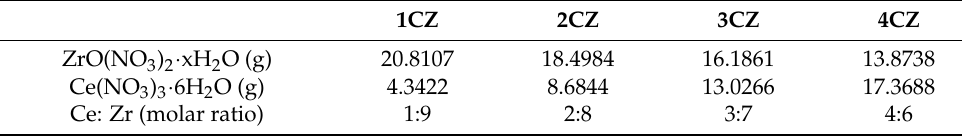
Table 1. CZ precursor solution preparation